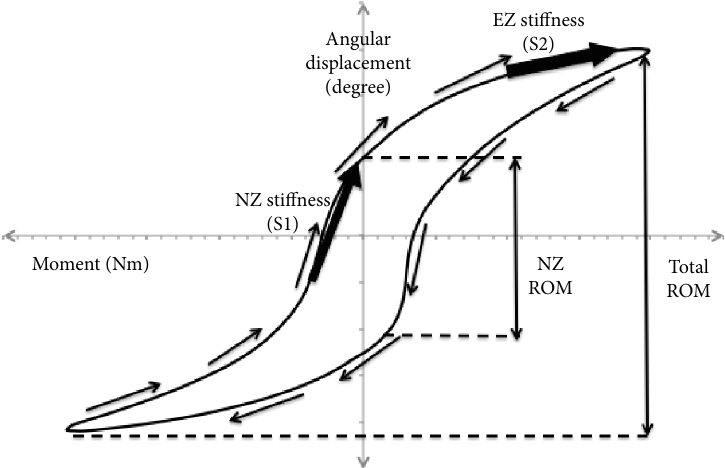
Figure 5: Typical sigmoidal curve of spine